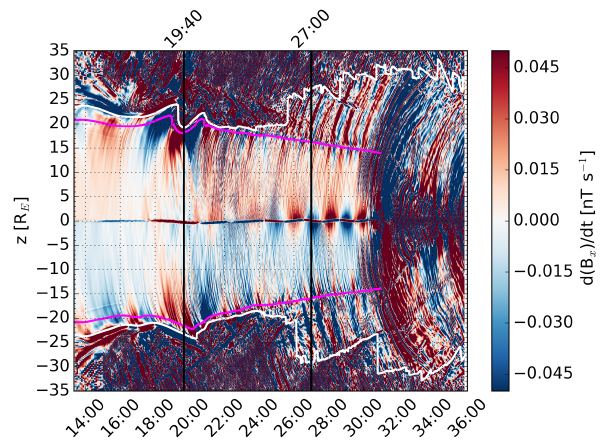
Figure 9. The same as Fig. 8 except that the color shows the time derivative of B x .